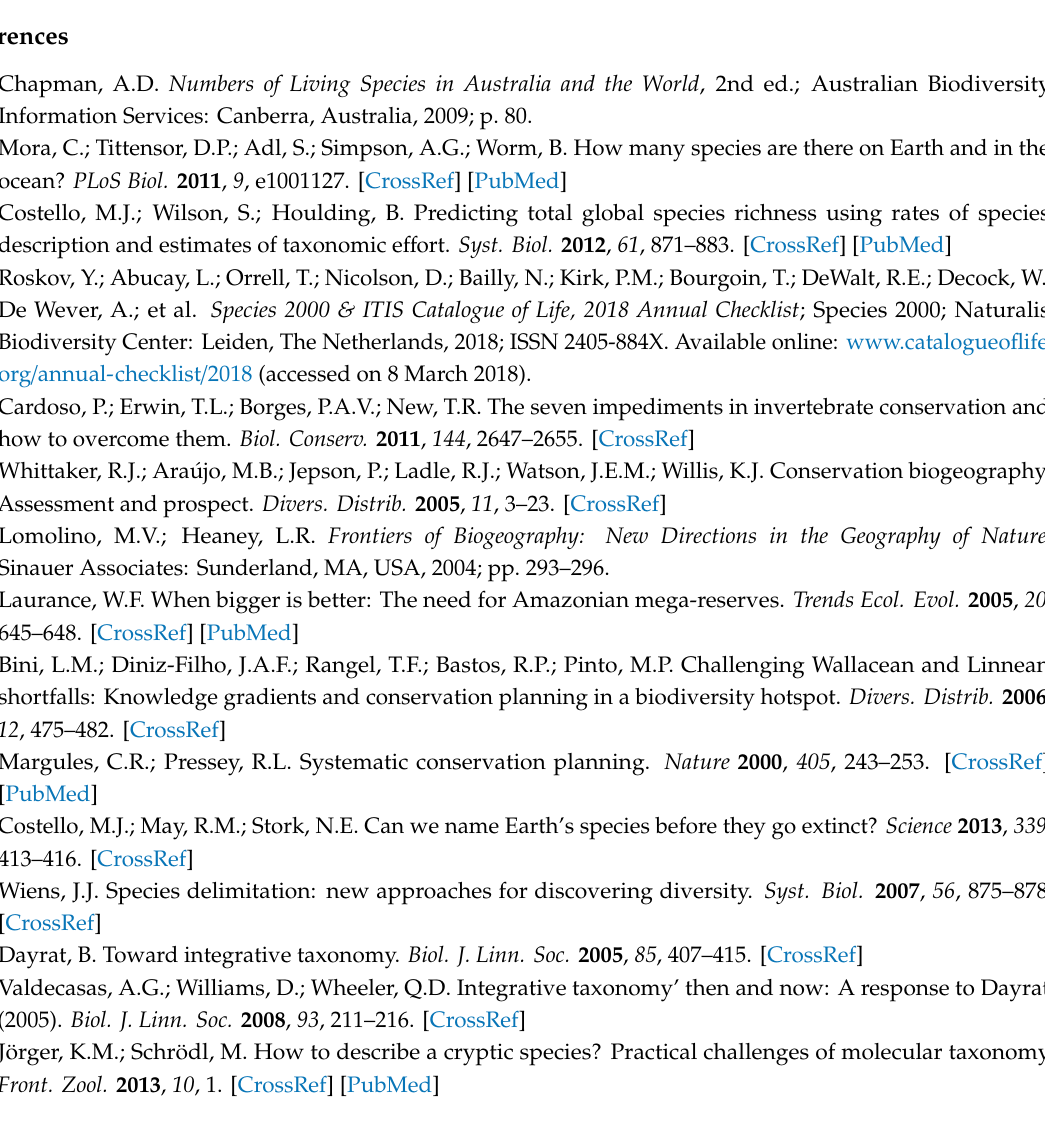
Table S1: Final dataset containing a total of 1261 papers with 4811 new